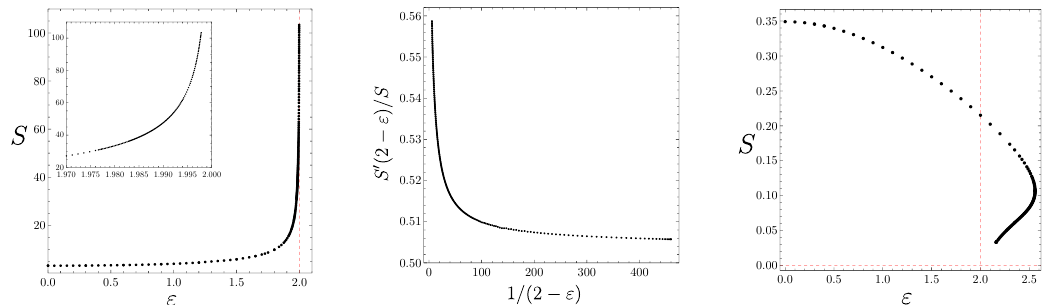
Figure 6 . Left : entropy against the rotation parameter " for the large branch of black holes with T = 1 =(cid:25) . The inset zooms around the limit, demonstrating the asymptotic behavior. Red dashed gridlines mark the " = 2 limit. Middle : logarithmic derivative of S for the large black hole with T = 1 =(cid:25) . As " ! 2, the entropy of the large black hole blows up as an inverse power law. Right : entropy of the small branch of black holes with the same temperature. Red dashed gridlines show where " = 2 and S =